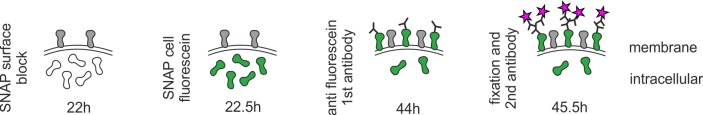
Staining procedure for recycled SNAP–ephrin-A5.Extracellular SNAP–ephrin-A5 was blocked by SNAP surface block (gray), before the cell-permeant SNAP cell fluorescein was applied to the living cells (green). After washing, axons were allowed to grow for another 20–22 hr. Then, anti-fluorescein antibody was added to the living cells for 15 min, washed out and, subsequently, explants were fixed and stained for anti-fluorescein (magenta stars).